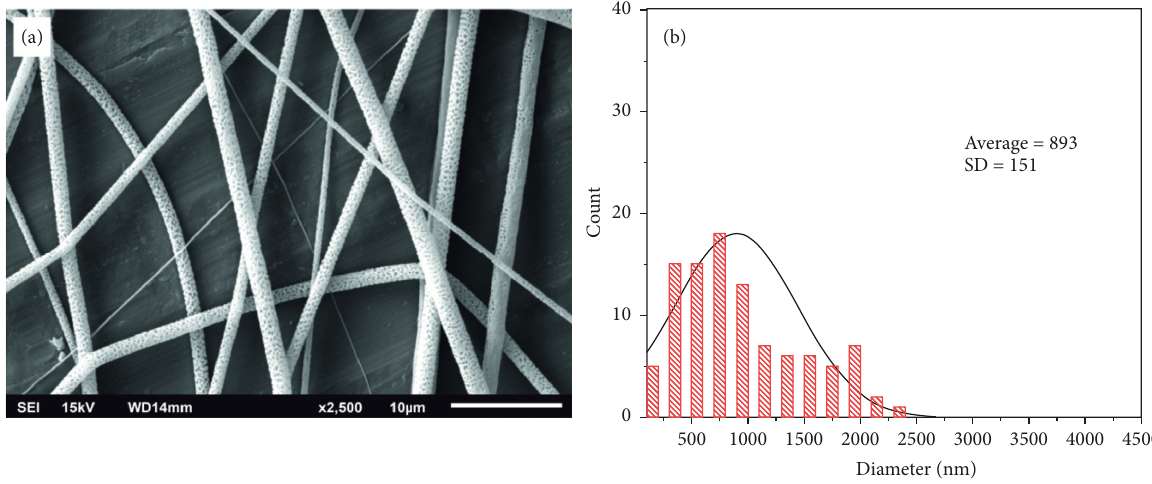
Figure 11: SEM micrographs of electrospun highly porous PLA (a) and histogram (b) (archive of